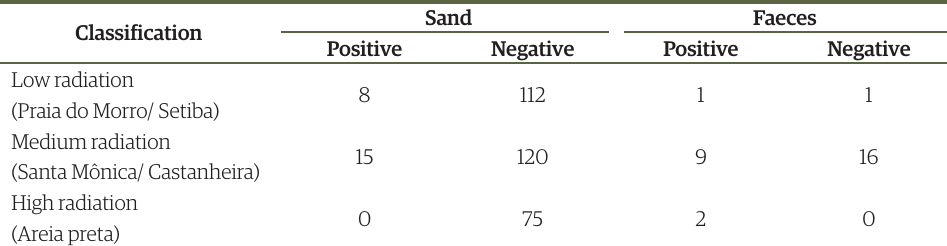
Table 3. Number of positive and negative samples for parasites with zoonotic potential observed in the sands and faeces of Guarapari beaches with low, medium and high